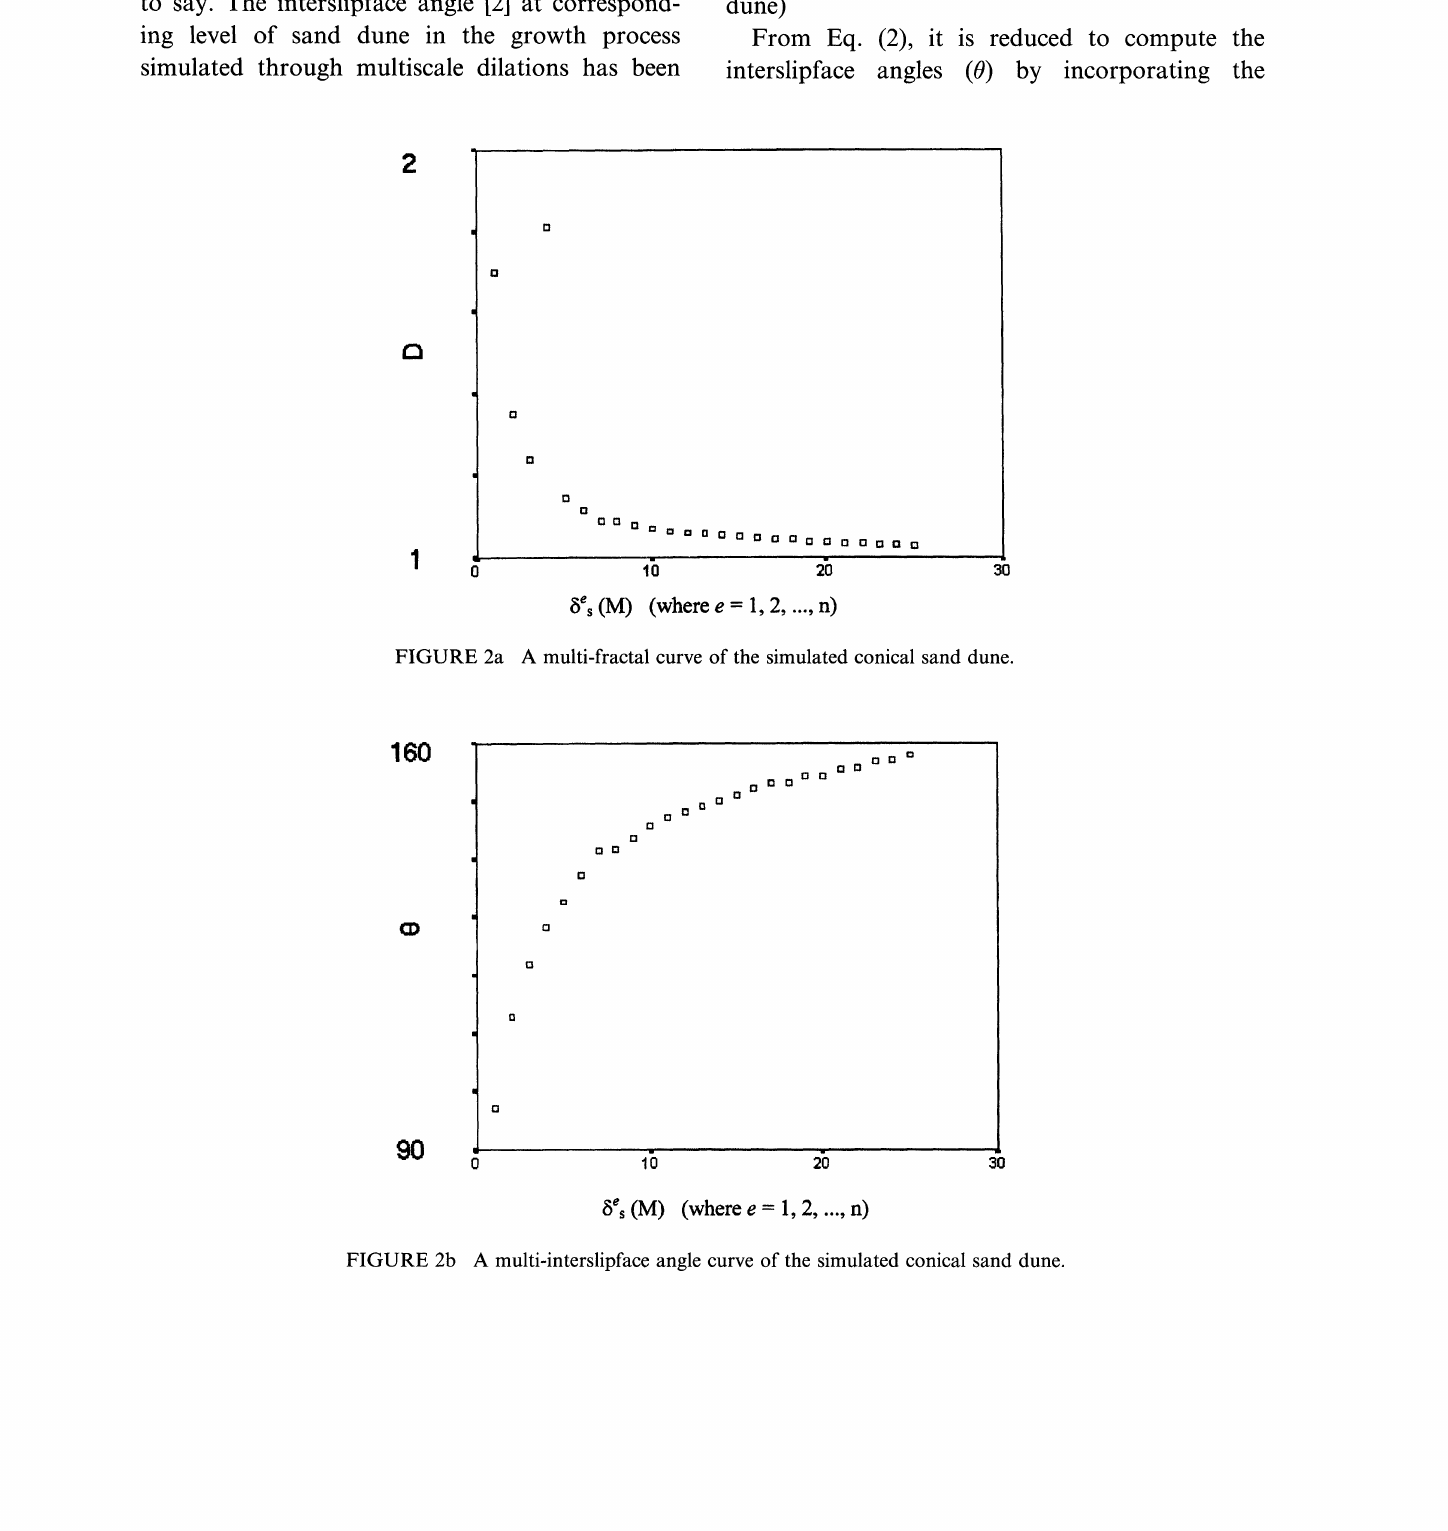
FIGURE 2a A multi-fractal curve of the simulated conical sand dune.